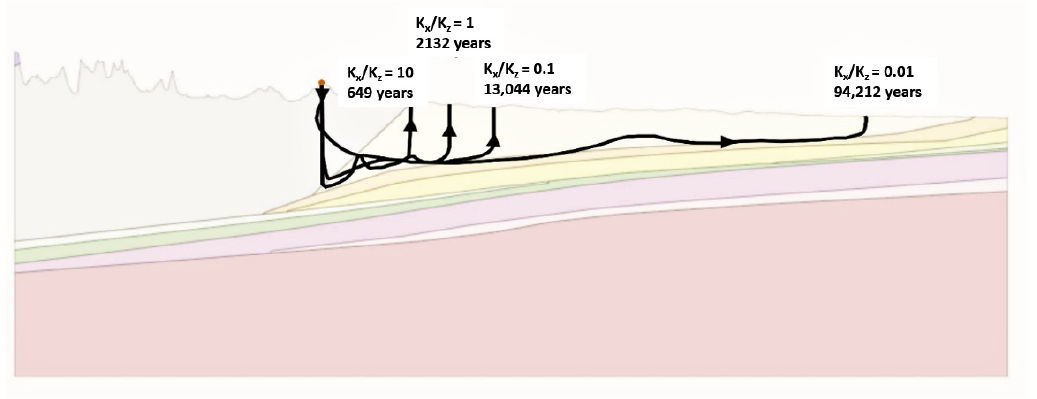
Figure 17. Sensitivity analysis for anisotropy of the entire model with effects on forward particle tracking times.